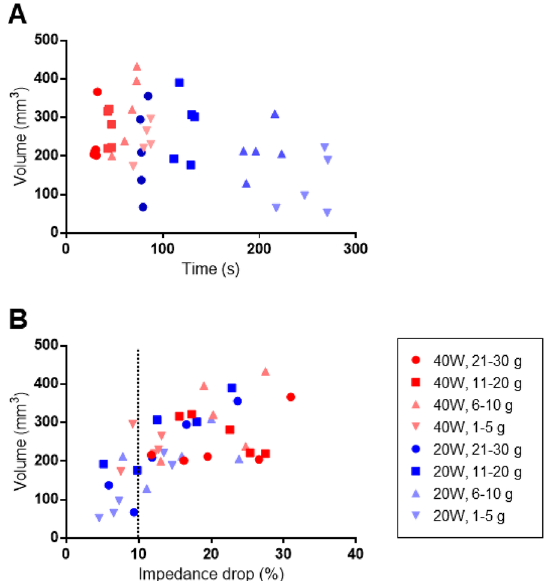
Fig. 1 A Lesion volumes and ablation time (s) for reaching ablation index 600. B Lesion volumes and impedance drop (%). Vertical dotted line indicates 10% drop of impedance during RF energy